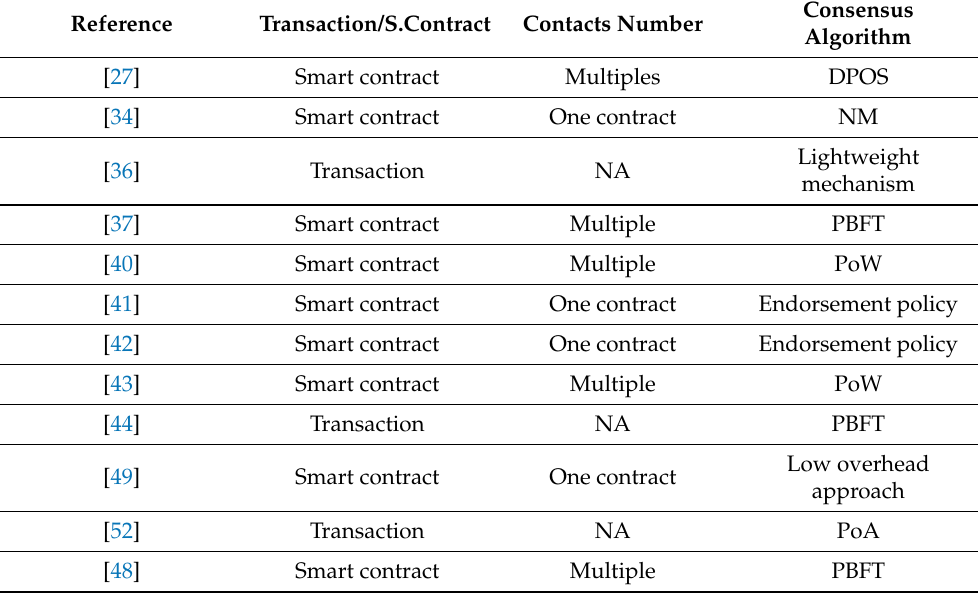
Table 4. Cr2 and Cr3